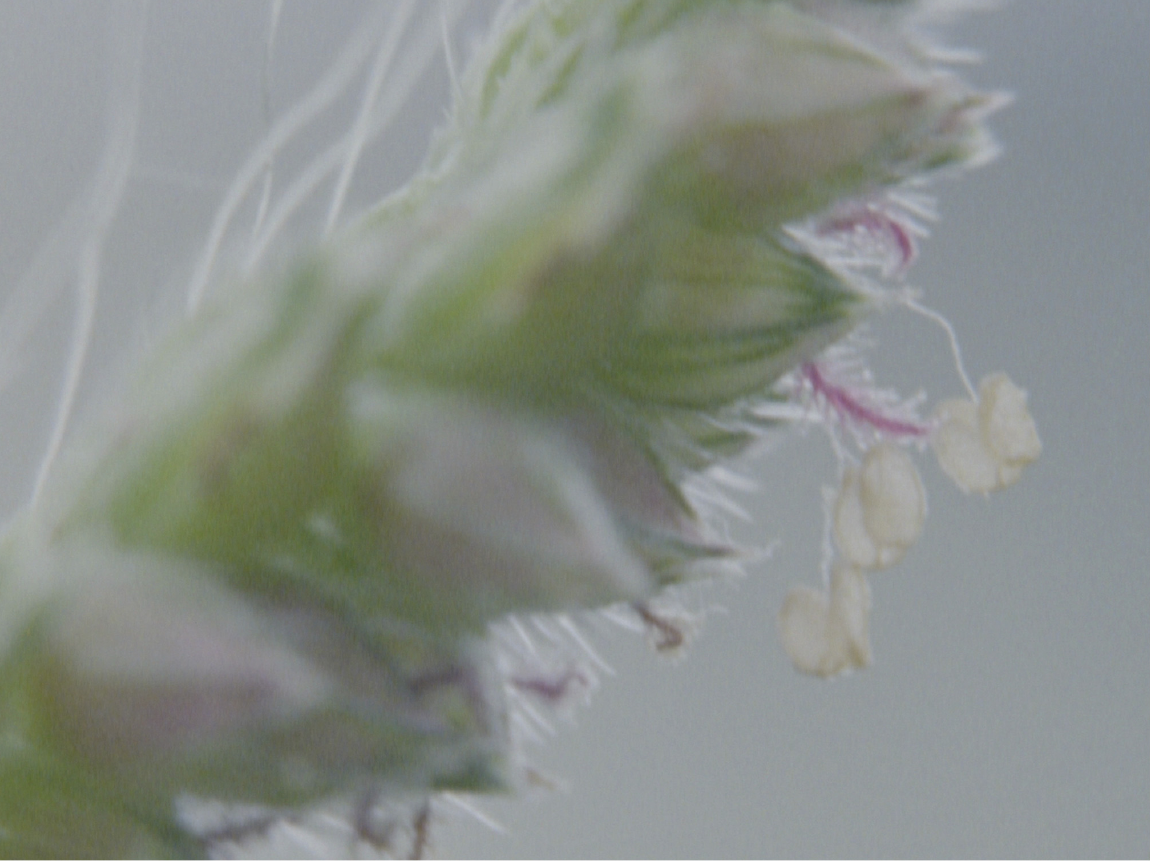
Figure 7. Wild millet, film still from Mikhail Lylov and Elke Marhöfer , Soil-Habit-Plants , 2017 (© Mikhail Lylov and Elke Marhöfer).